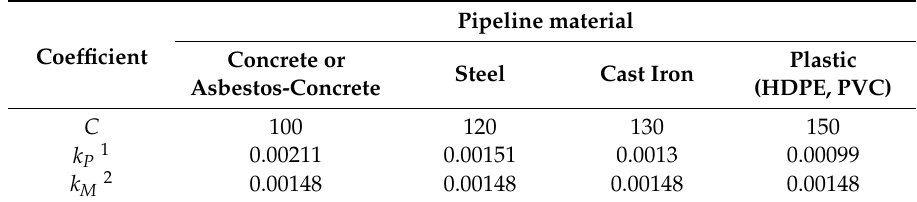
Table 1. Coefficients of Hazen-Williams’ formula used in the methods for evaluating SHP energy production in seven irrigation systems of Calabria (Southern